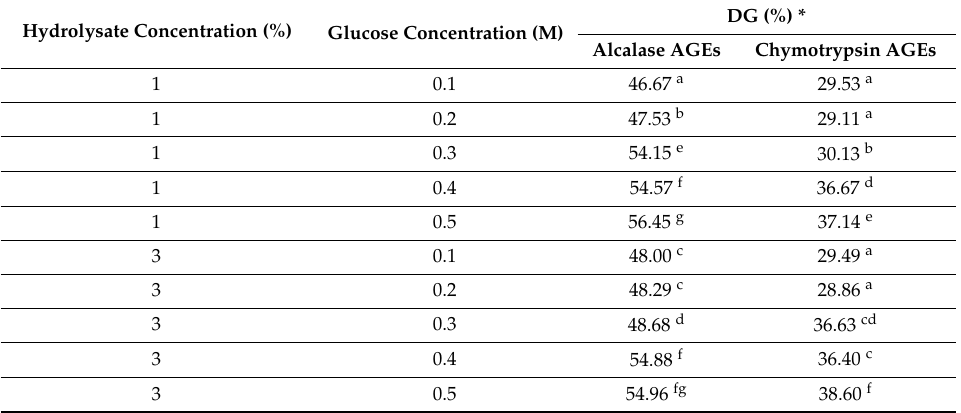
Table 2. Degree of glycation (DG) for alcalase hydrolysate and chymotrypsin hydrolysate advanced glycation end products